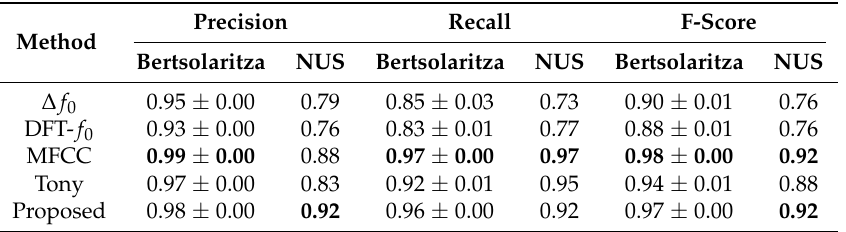
Table 4. Results of singing classification.